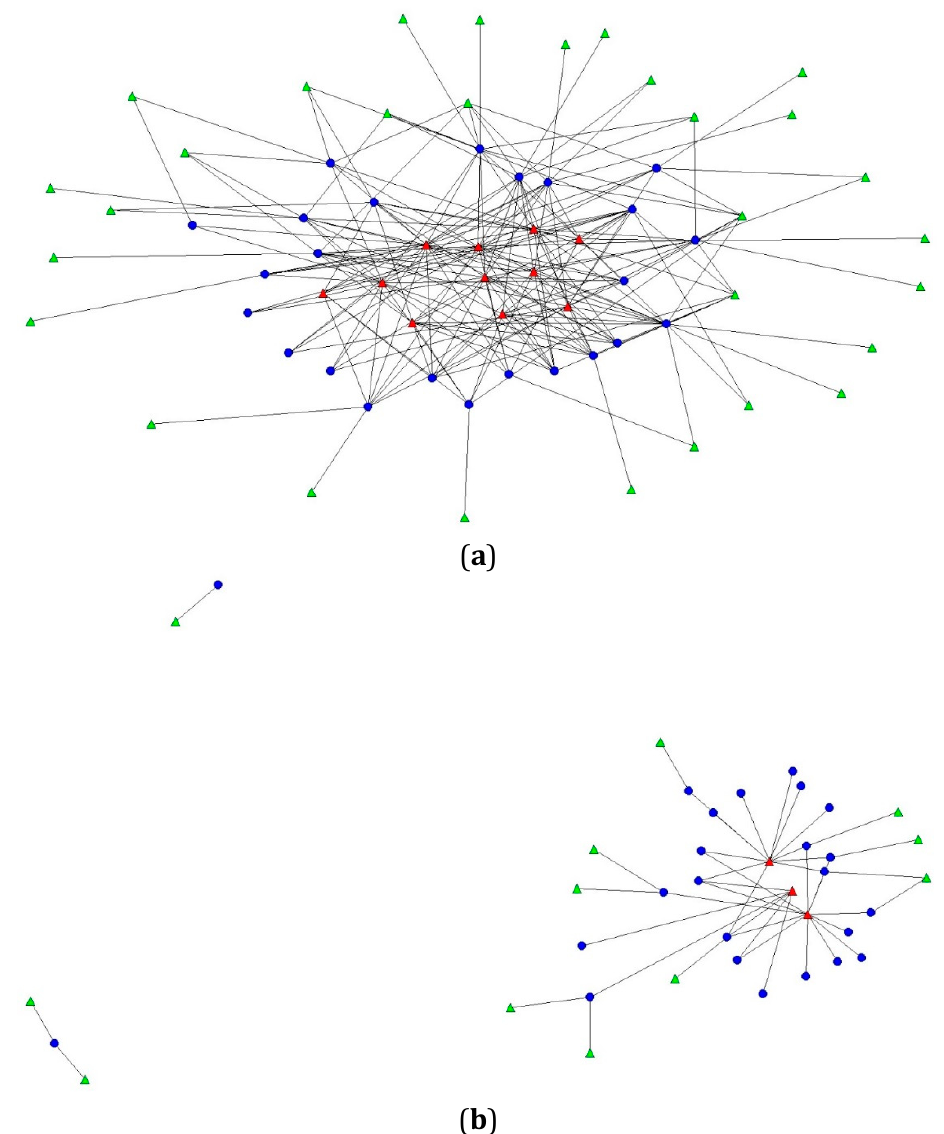
Figure 1. ( a ) Two-mode sociogram depicting relationships in corner stores’ unhealthy supplier network (UHSN) in Baltimore City, MD; triangles represent the food and beverage suppliers in corner stores’ UHSN (red triangles are core suppliers); circles represent the corner stores; edges (line) represent a connection between a corner store and a supplier; ( b ) Two-mode sociogram depicting relationships in corner stores’ healthy supplier network (HSN) in Baltimore City, MD; triangles represent the food and beverage suppliers in corner stores’ HSN (red triangles are core suppliers); circles represent corner stores; edges (line) represent a connection between a corner store and a supplier.